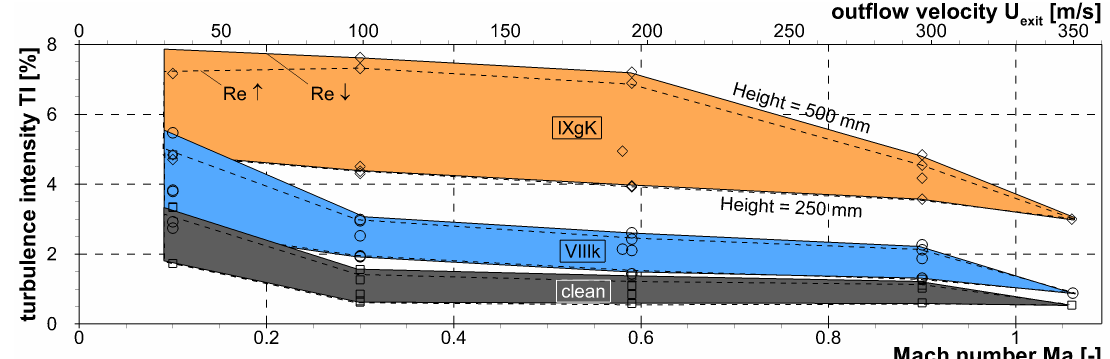
Figure 9. Distribution of the integral turbulence intensity TI across the HGK’s entire performance map. TI was measured with 2D-3C PIV and averaged between y / H = ± 0.1 without turbulence generator (black-clean) and for both turbulence grids (blue-VIIIk) and (orange-IXgK).